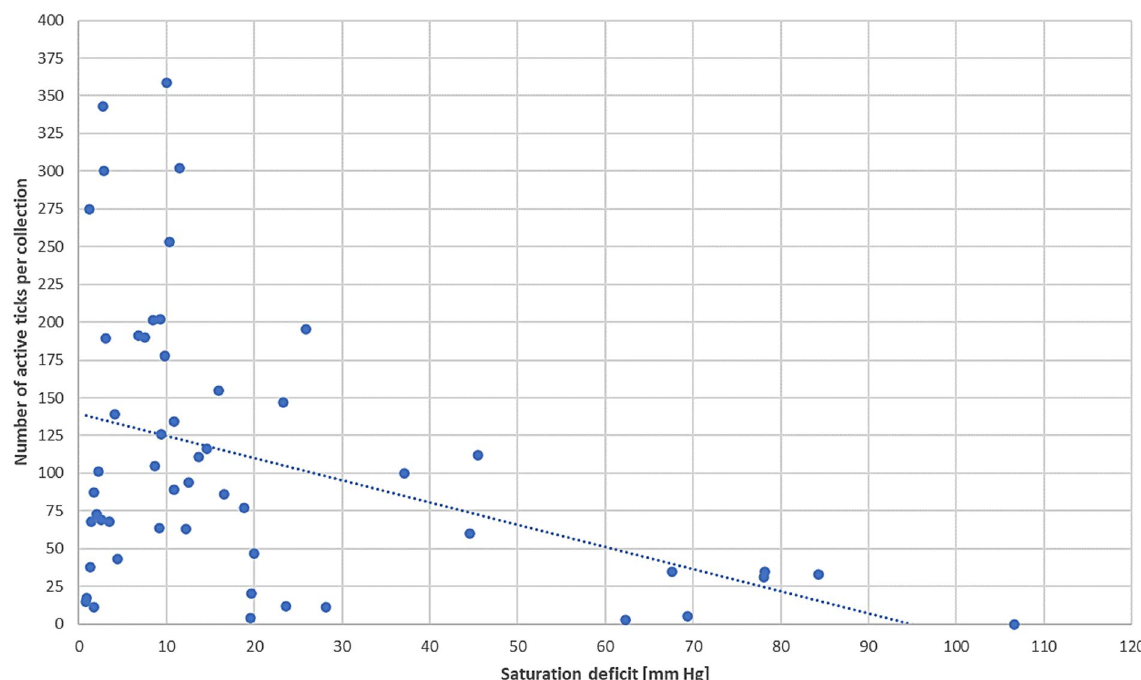
Figure 3. Correlation between the value of the saturation deficit and the number of active D. reticulatus